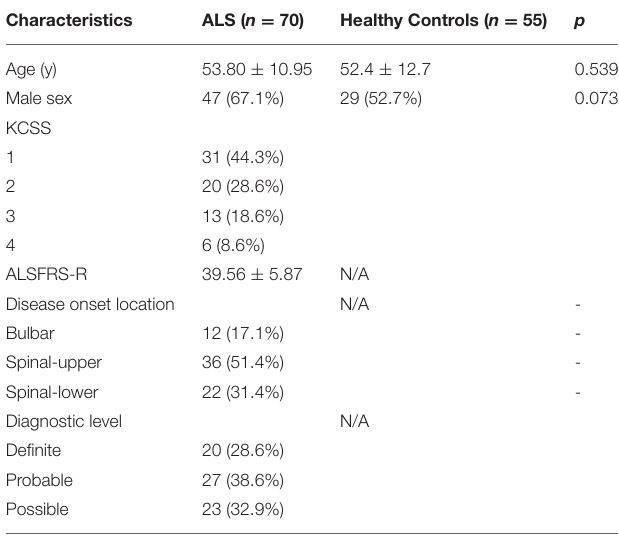
TABLE 1 | The demographics and general clinical characteristics of the ALS patients and healthy controls.